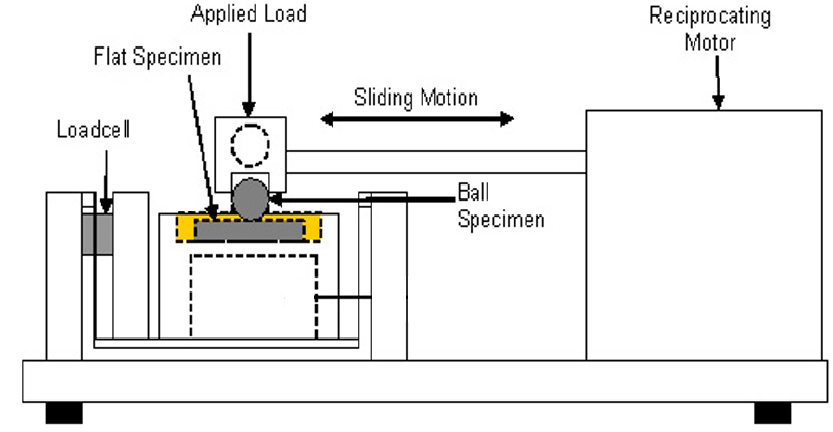
Figure 1: Schematic view of wear testing machine.